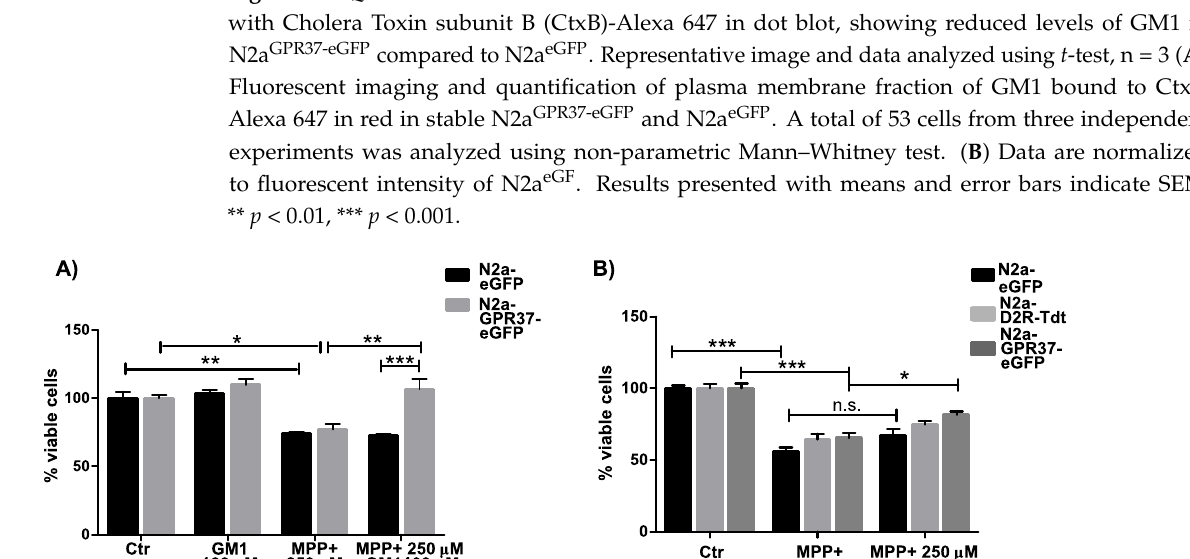
Figure 2. GPR37-specific rescue with 24 h GM1 pretreatment (100 µM) against MPP+ treatment in stable N2a GPR37-eGFP compared to N2a eGFP measured by resazurin assay 24 h after toxin addition. ( A ). Transiently transfected N2a showed the same pattern with GPR37-specific rescue with GM1 treatment (50 µM) 48 h after MPP+ addition. ( B ) Data from three independent experiments. Fluorescence is normalized to the average of control condition. Two-way ANOVA followed by Tukey post hoc test. Error bars indicate SEM. * p < 0.05, ** p < 0.01, *** p < 0.001; n.s., non-significant.